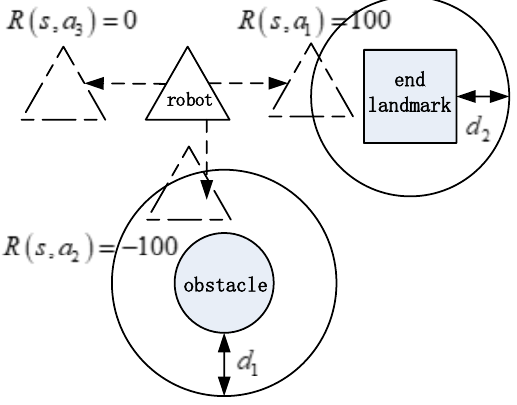
Figure 4. Penalty factor and incentive factor.